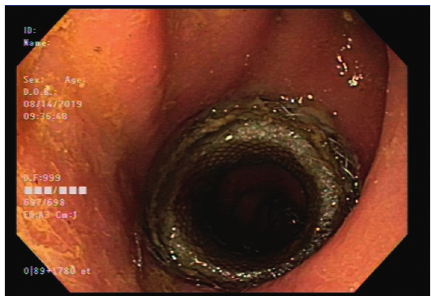
Figure 4: Flexible sigmoidoscopy illustrating a patent LAMS in place over an anastomotic